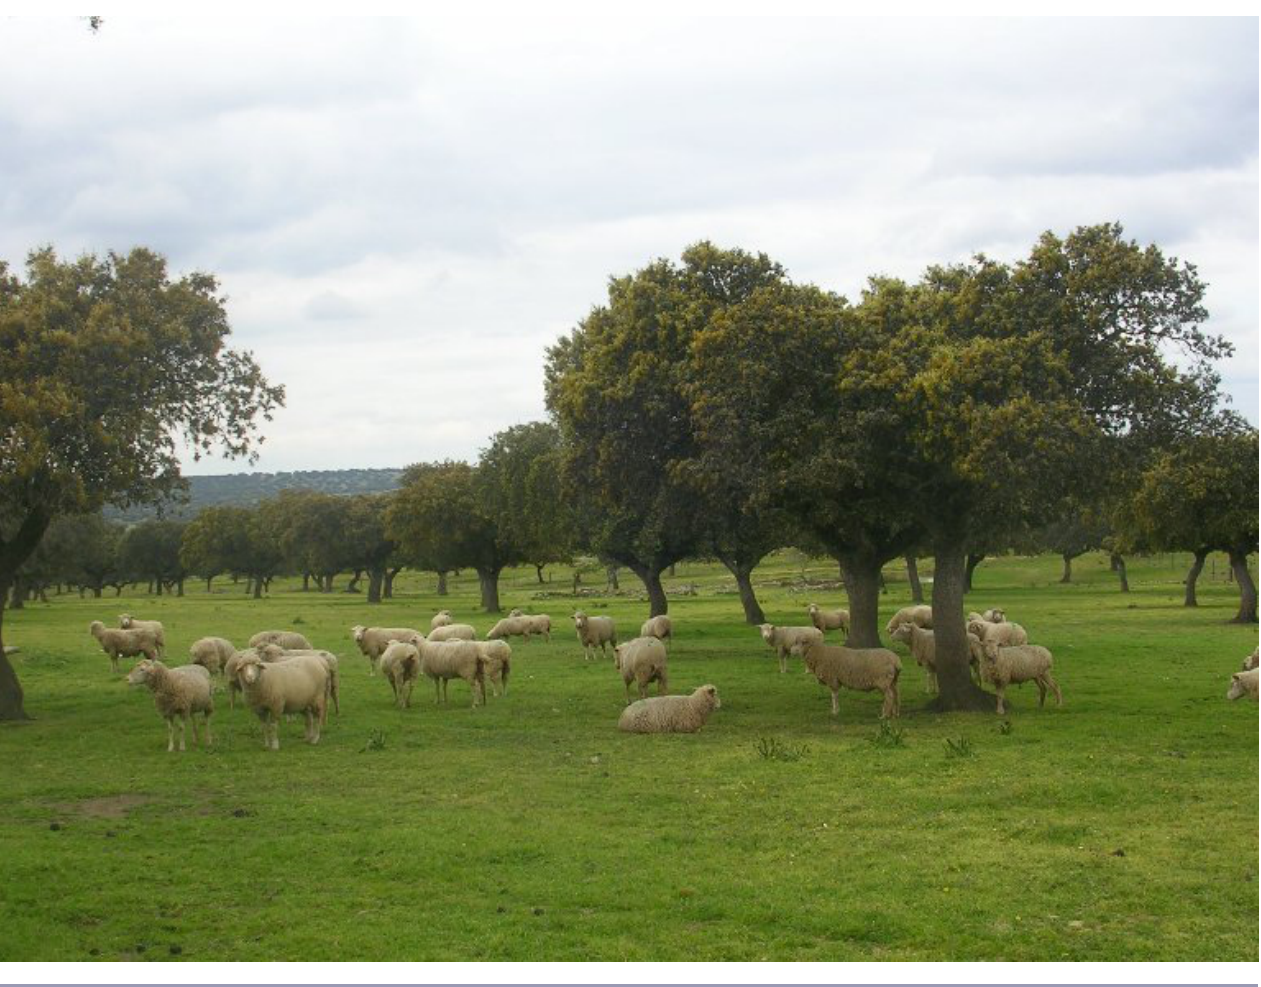
Fig. 2 . Sheep grazing in a dehesa with scattered holm oaks (Parapuños de Doña María site, April 2007). Obviously, tree regeneration is almost